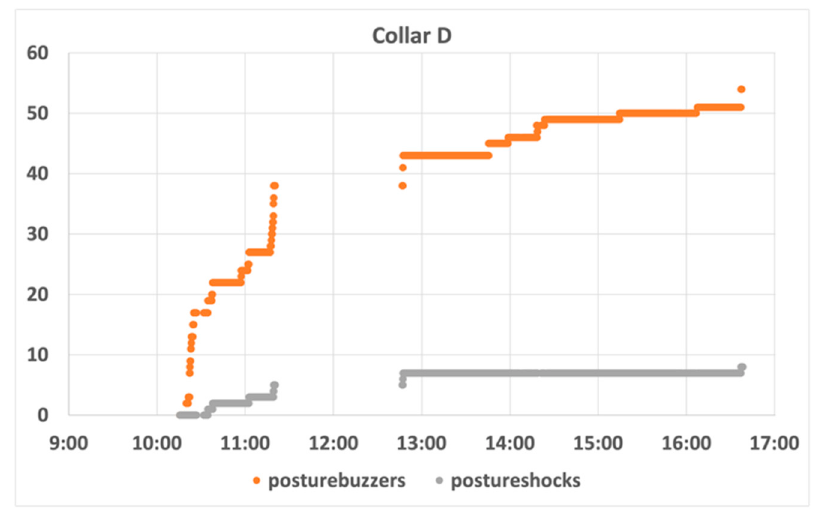
Figure 10. Collar D behaviour analysis.